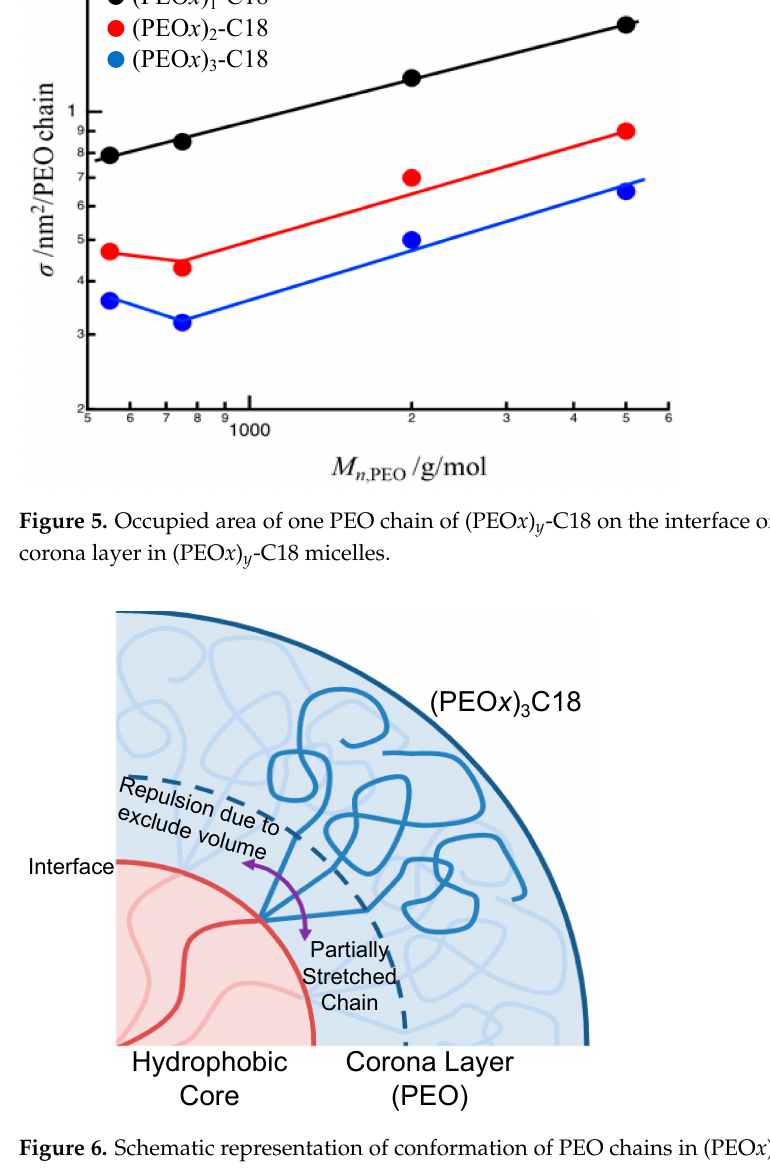
Figure 6. Schematic representation of conformation of PEO chains in (PEO x ) 3 -C18 micelles.